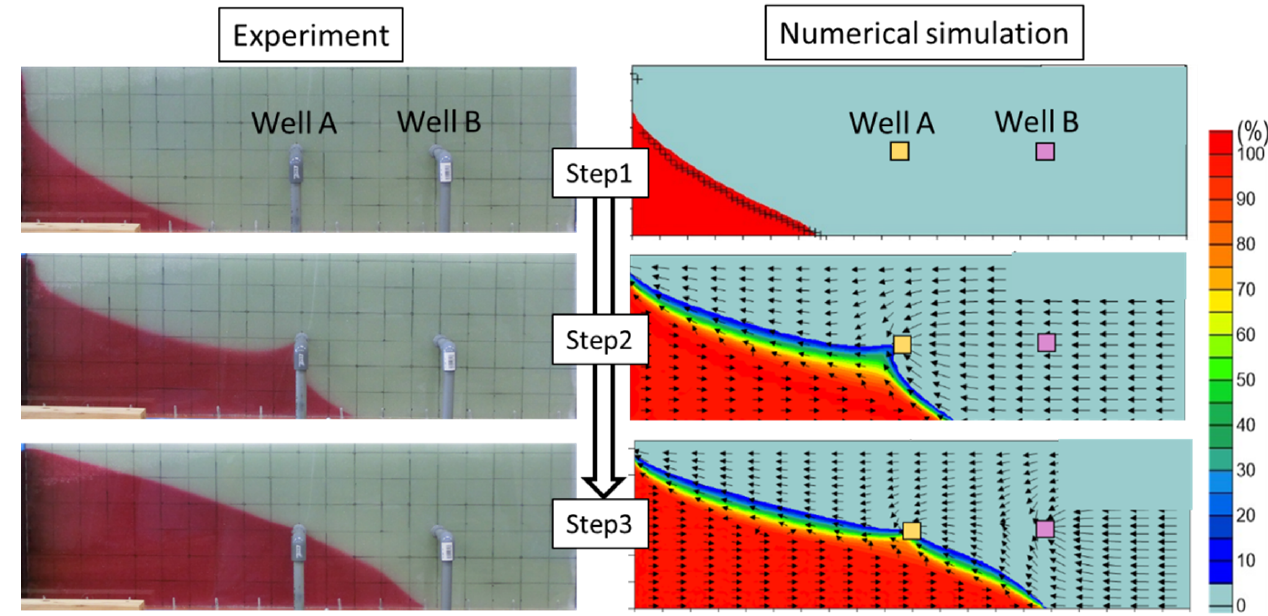
Figure 9. Experimental and numerical simulation results (steady states in each step) for R = 1.9.